Question: What caption would you write for this figure?
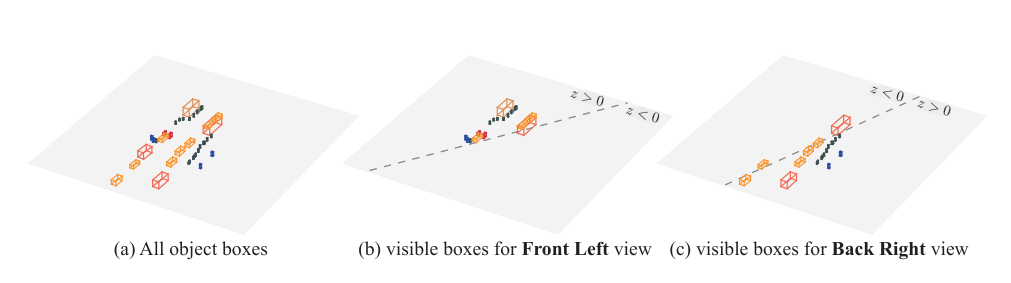
Answer: Bounding box filtering to each view. The dashed lines in (b-c) represent the x-axis of the camera’s coordinates. Boxes are retained only if they have at least a point in the positive half of the z-axis in each camera’s coordinate.